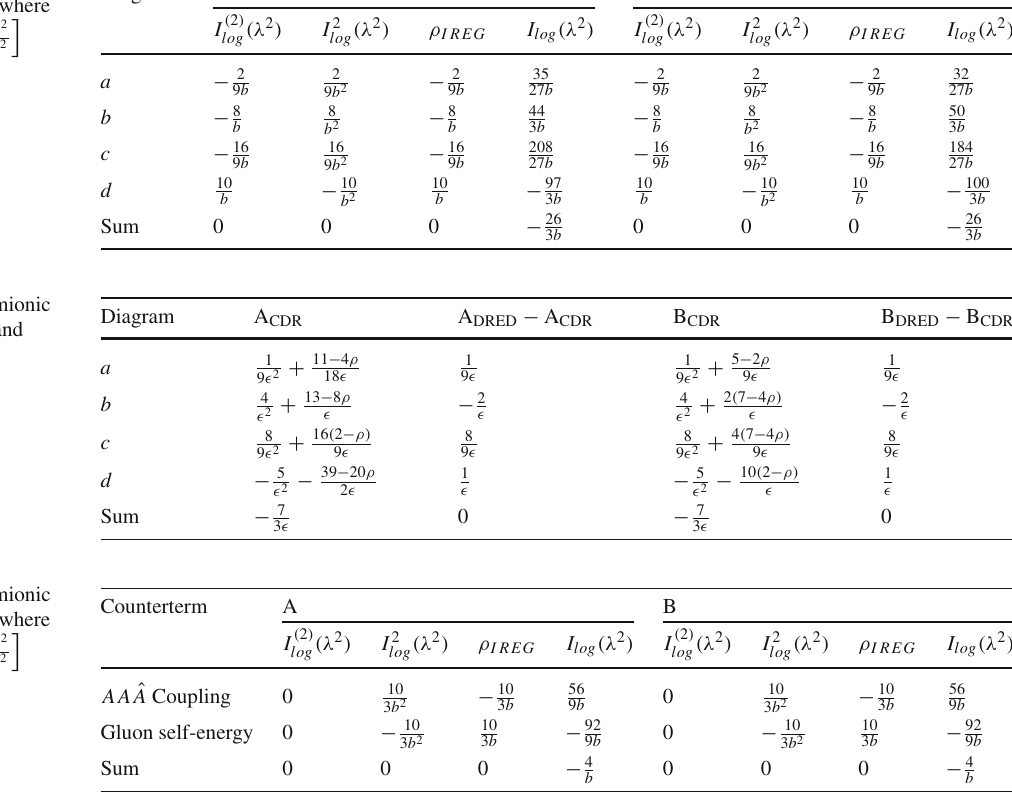
Fig. 5 Two-loop correction to the two-point function of the background field – fermionic contribution of QCD Table 15 Results for fermionic part of QCD using IREG where